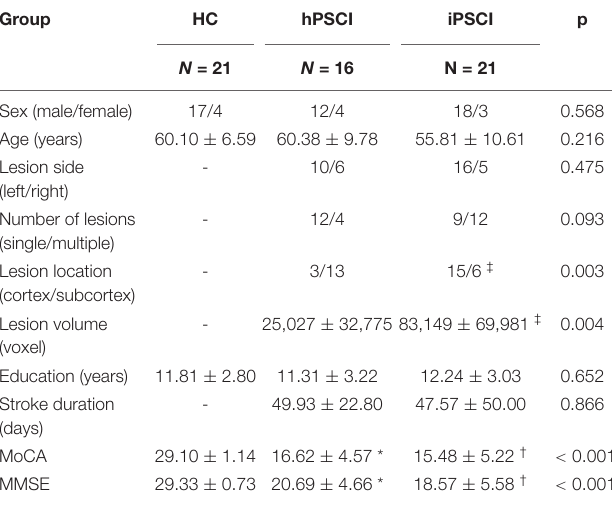
TABLE 1 | Baseline of demographic and clinical